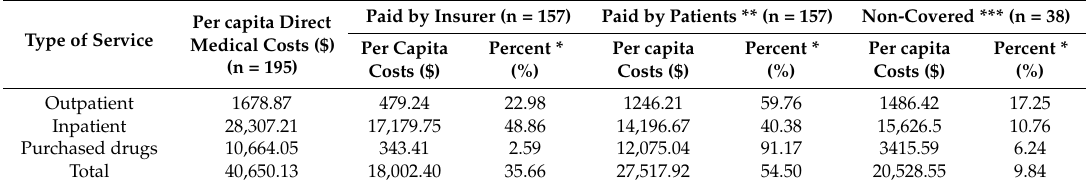
Table 3. Medical expenditures payment by type of medical service.